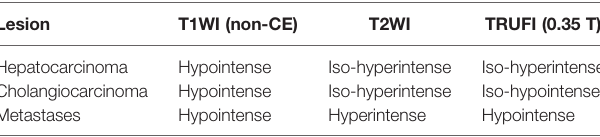
TABLE 2 | Liver lesions in the different MR sequences in current MRgRT clinical use.